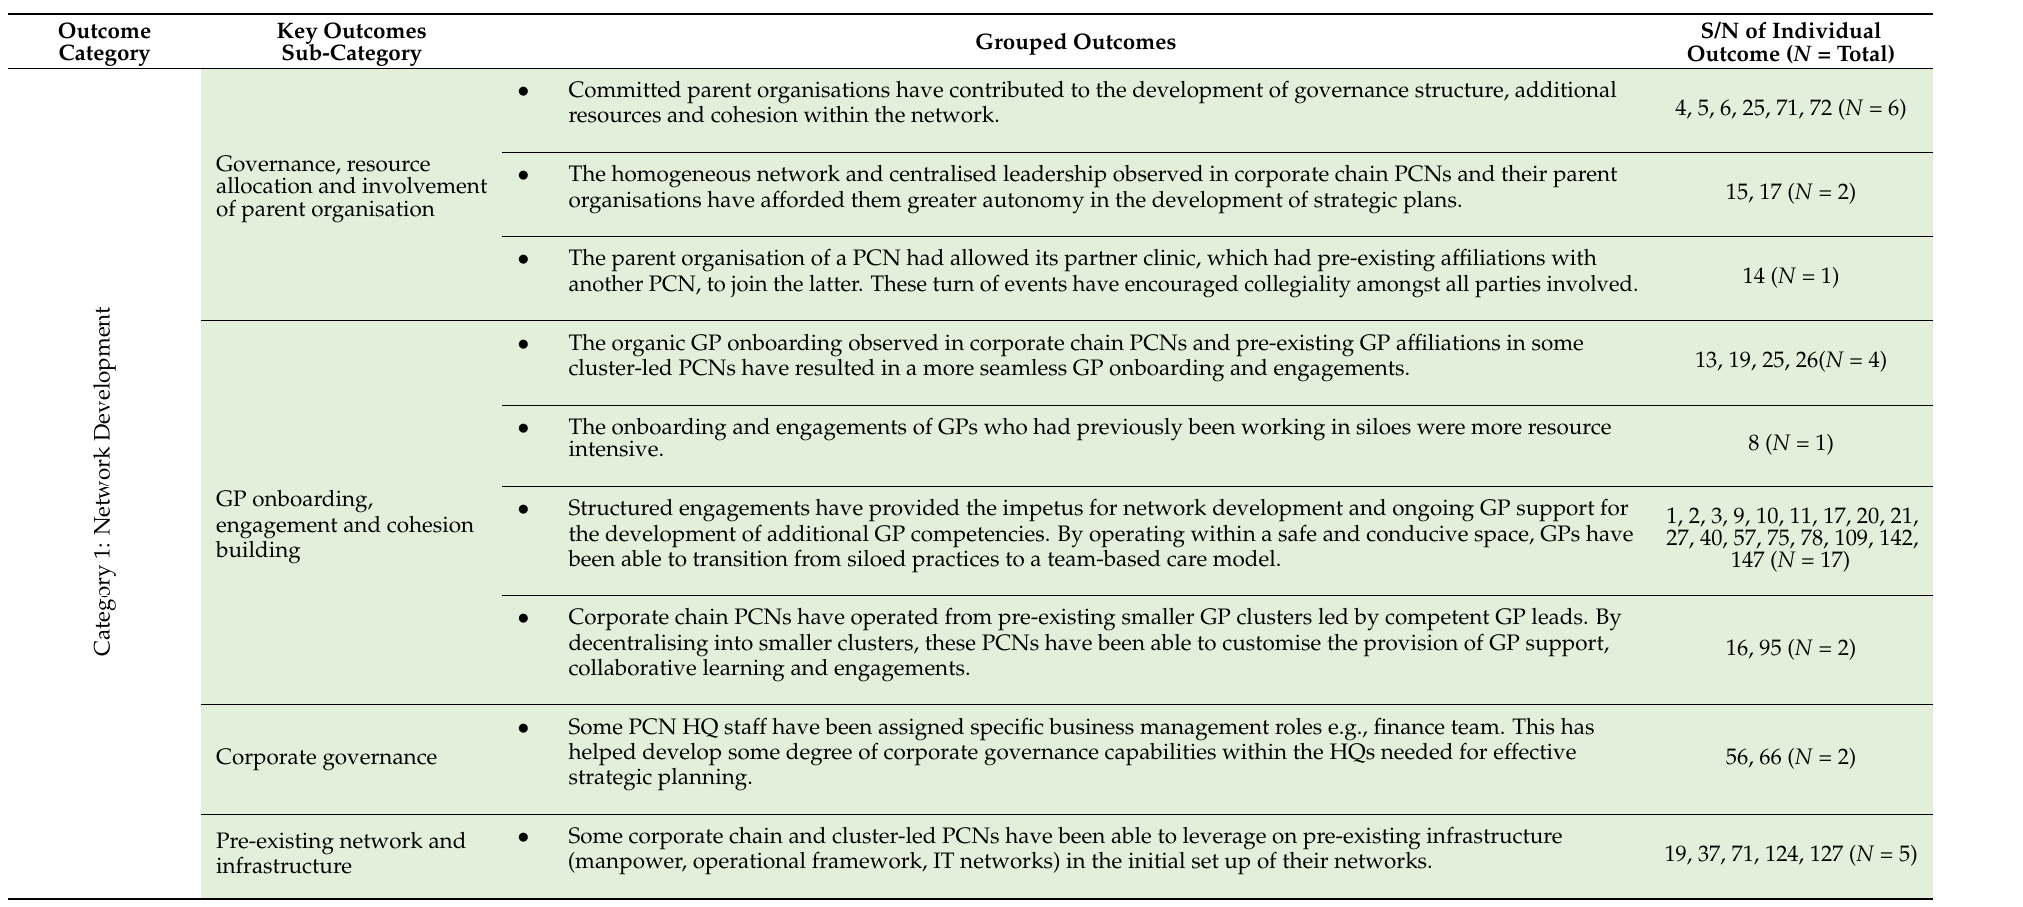
Table A4. Matrix of thematic outcome categories a , outcomes were dichotomised using a traffic lights system to highlight positive and negative effects b